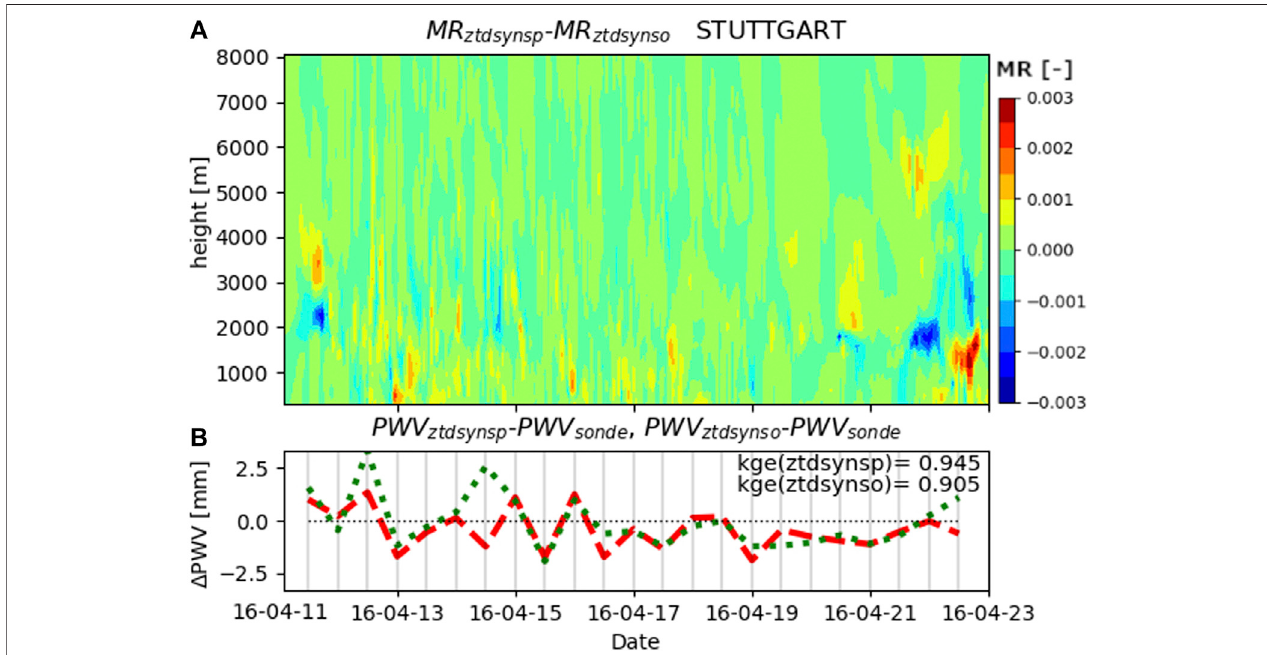
FIGURE8| Differenceofthemixingratio(MR)withheight (A) forthecombinedassimilationofZTDandsynopticdatabasedontheBEobtainedinApril2016(spring episode,red)andtheBEobtainedinJuly2018(summerepisode,green)attheStuttgartlocationforthespringepisodeanddifferenceofcorrespondingPWVvaluesand radiosonde data (B) .